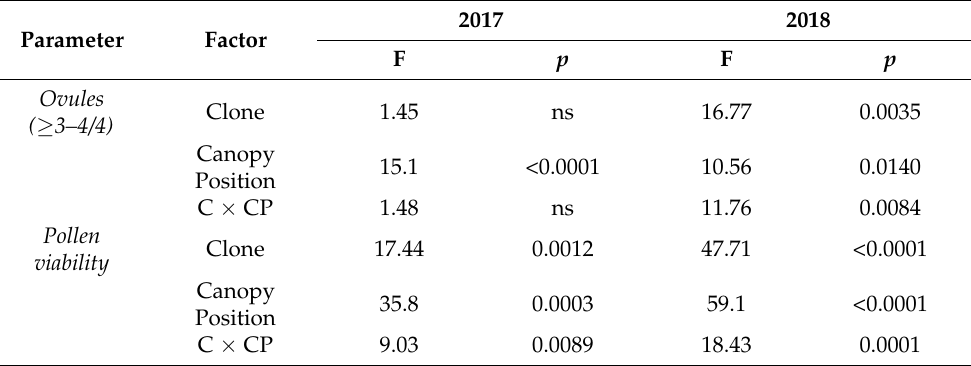
Table 2. Two-way ANOVA results relating to the quality parameters of female and male reproductive organs represented by ovaries with ≥ 3–4/4 ovules and pollen viability. Main effect: clone (C), canopy position (CP). F- and p -values are shown; ns: not significant. Data of pollen germination are not reported because differences between clones and canopy position were never